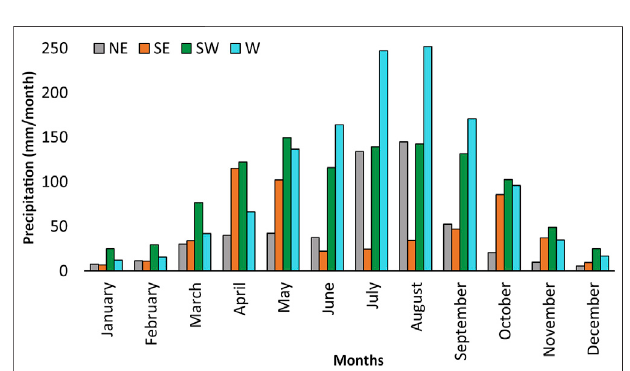
FIGURE 3 | Climatological annual cycles of precipitation (mm/month) from the Climatic Research Unit (CRU) (TS4.05) datasets, over the NE (grey), SE (orange), SW (green), and W (cyan) river basin groups. Period of study: 1980 – 2018.